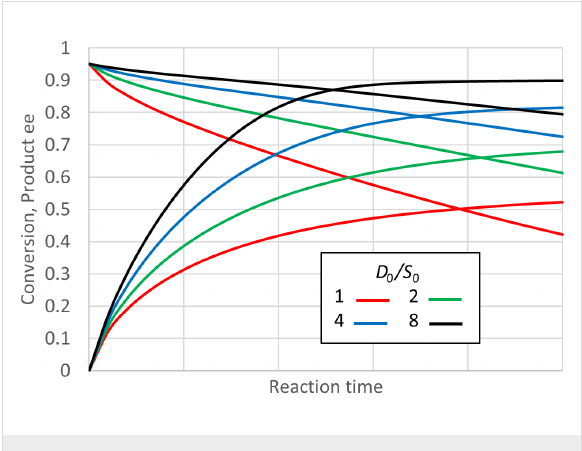
Figure 4: Reaction progress for “ping-pong, second” kinetics, and the effect of the ratio of donor to prochiral substrate. S 0 = 0.2 M, K eq = 1, E = 39, K MD = 0.2 M, K MS = 0.01 M, k 2 = 1000 s − 1 , SCRf / b = 1, k 2 / k 4R = 1, E · k 4S / k 4R = 1, k − 1 / k 2 = 1, k 3R / k − 4R = 1, k 3S / k − 4S = 1. Again the enzyme concentration was adjusted such that all initial rates